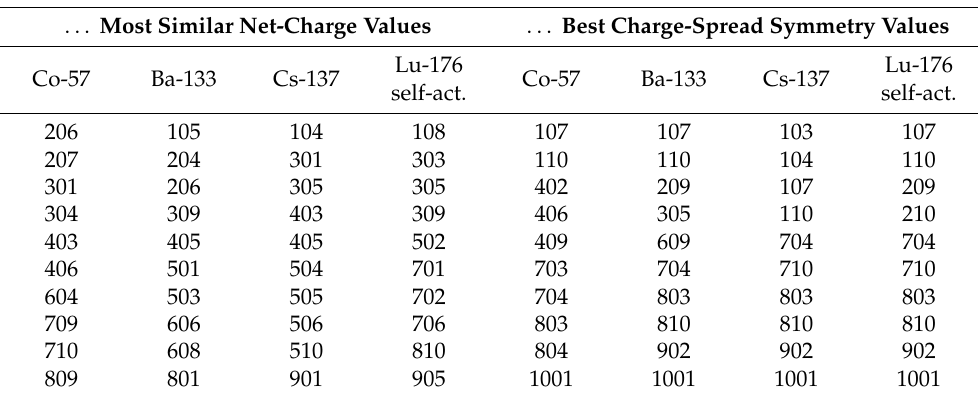
Table 4. Decuples of crystal-pixels having the most similar net-charge Q net average values, and the best charge-spread 2-D symmetry Fsym average values, per data-token. Crystal-pixels are referred to by the CCRR notation. The 10 pixels of the 10 × 10 Array Having the . .